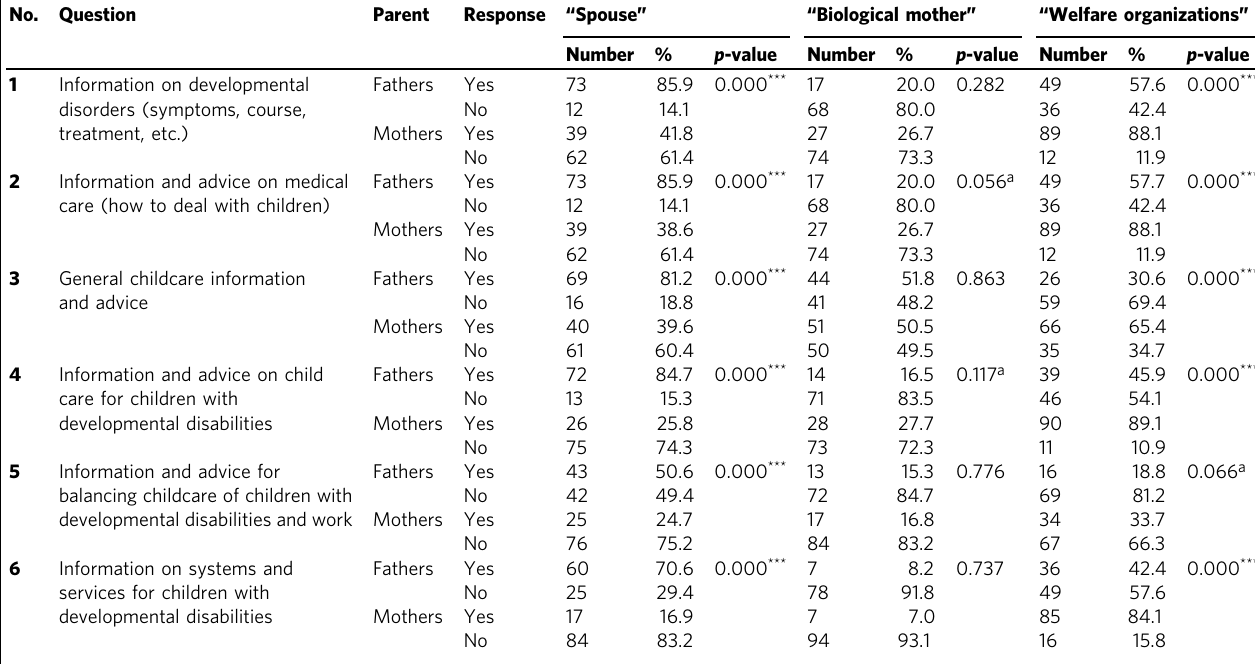
Table 3 Information support survey